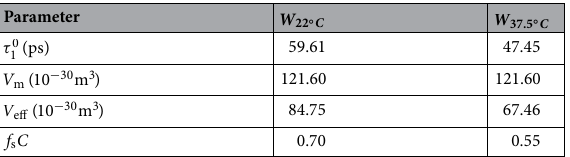
Table 2. Relaxation times of GABA at the infinite dilution under two conditions: GABA dissolved in deionized water at 22 ◦ C and 37.5 ◦ C . Table shows the calculated effective rotational volume, V eff , the calculated ( f s C ) product which accounts for deviations of the GABA molecule from a spherical shape and the coupling between GABA molecule and its surroundings. We used the experimental GABA molecular volume ( V m ) value as described by Sirimulla et al. 10 , expressed as volume per molecule.